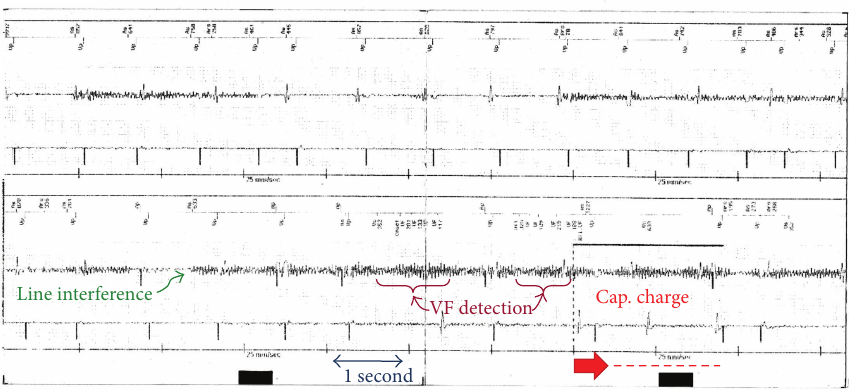
Figure 2: Detail of the intracardiac EGM atrium and ventriculum. Power line interferences clearly visible on EGM (thickening of signal); it followed VF detection (purple arrows) and the start of the capacitor charge (red